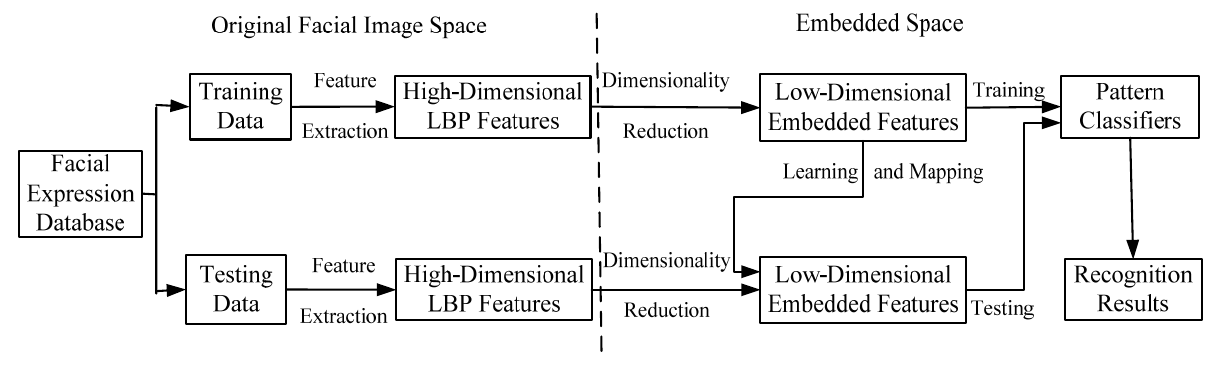
Figure 6. The basic system structure for facial expression recognition experiments using dimensionality reduction